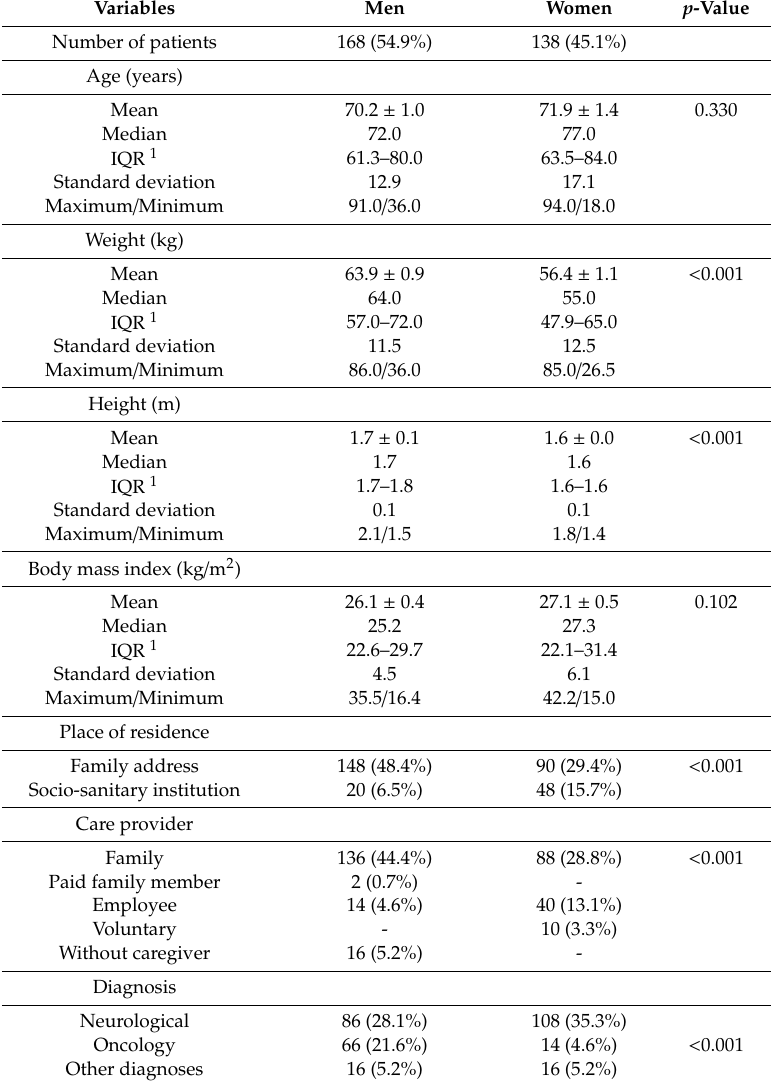
Table 1. Descriptive data related to the study